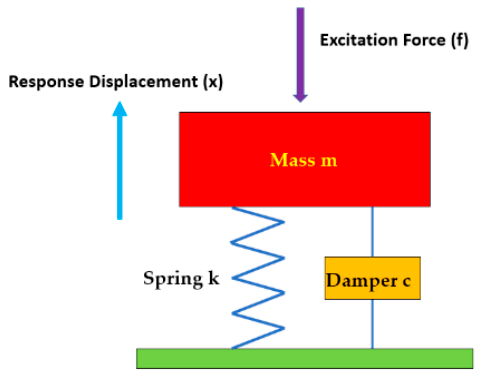
Figure 10. Demonstrating a SDOF discrete parameter model.